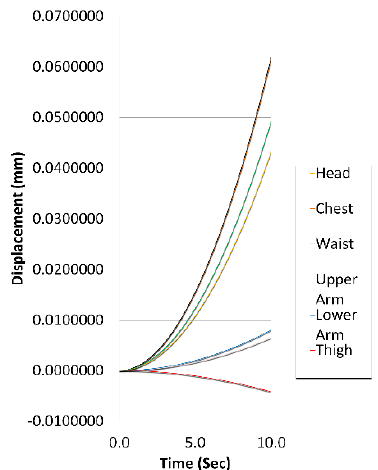
Figure 5. Vertical accelerations of the points of interest.